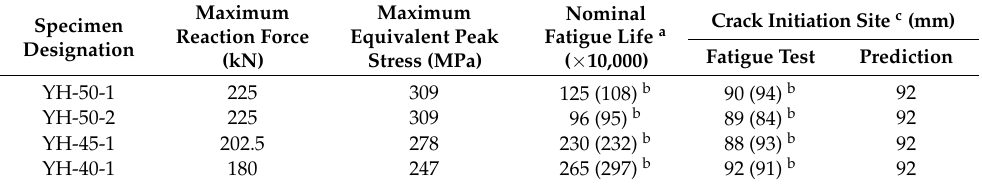
Table 1. Fatigue test results of the variable-section supports with R-plates and three-web